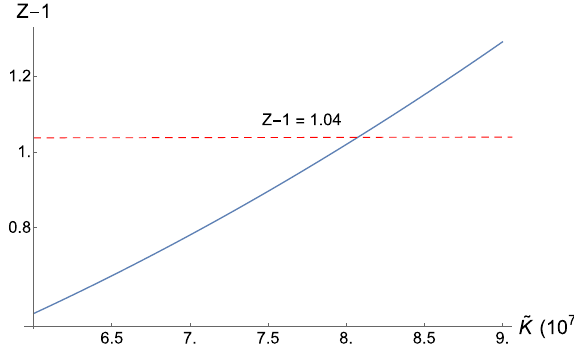
Fig. 2 Plot of Z − 1 factor versus the (rescaled) Kaniadakis